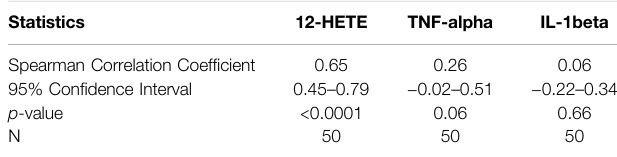
TABLE 4 | Vaso-occlusive events scores and plasma cytokine levels (pg/ml) in sickle cell